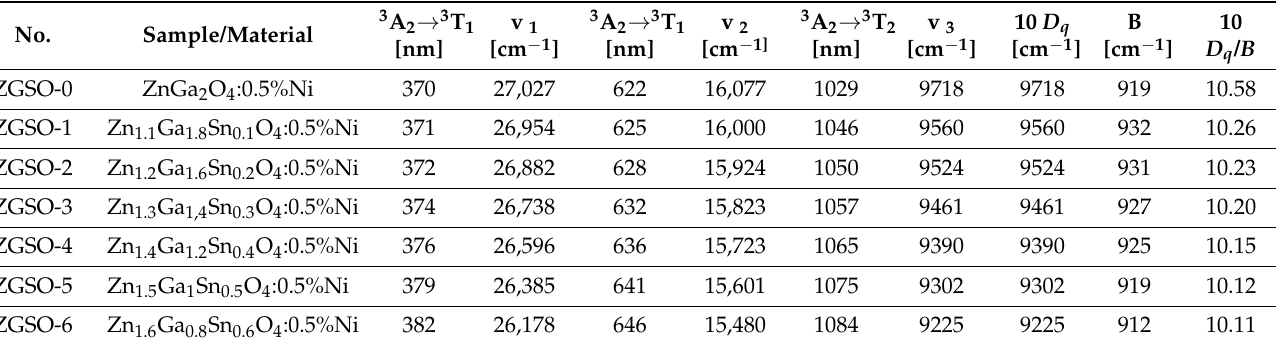
Table 1. Peak position of absorption and estimated crystal field parameters of Ni 2+ in the spinel samples ZGSO.